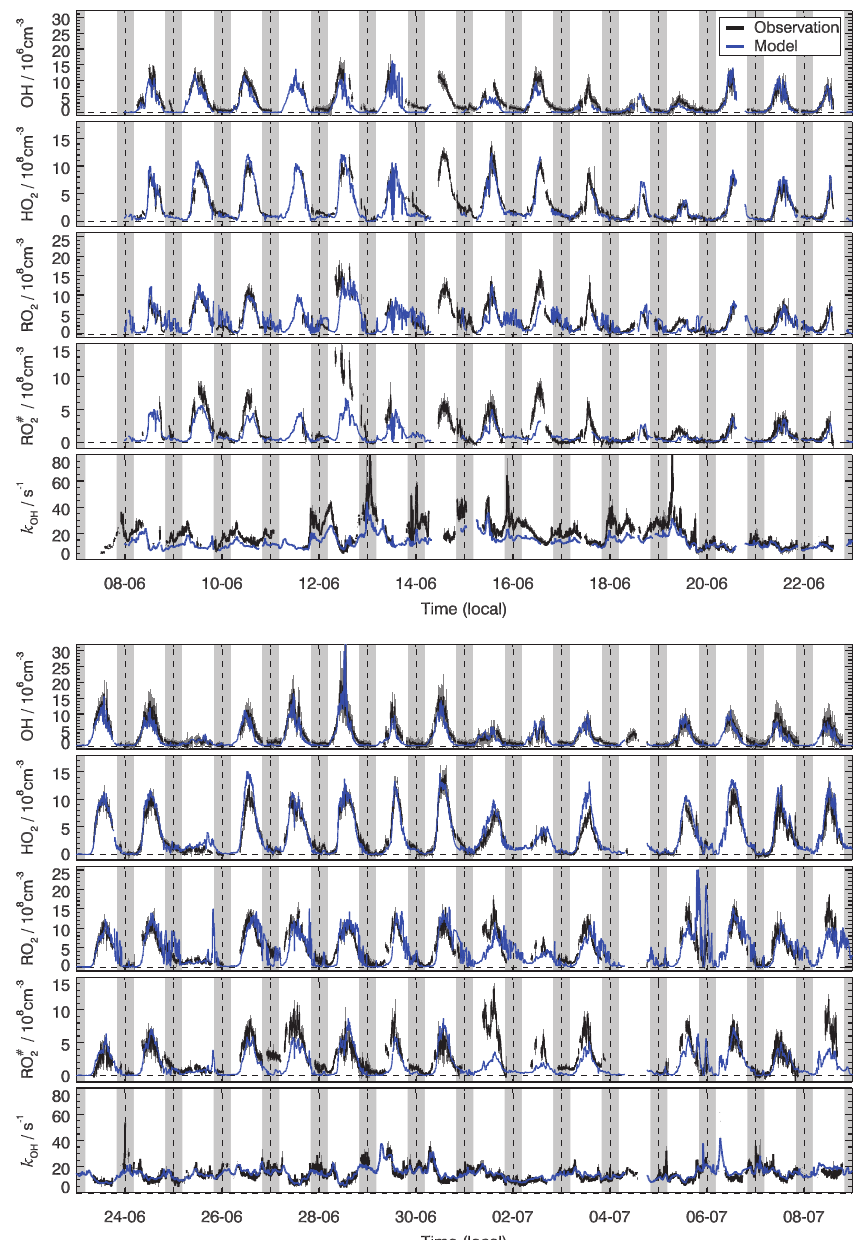
Figure 4. Time series of measured and modeled OH, HO 2 , RO # , total RO 2 concentrations and k OH . Vertical dashed lines denote mid- 2 night. See text for details on the definition of RO # and total RO 2 . Grey vertical lines denote 1 σ standard deviation for measured radicals’ 2 concentration with respect to 5min variability. Grey areas indicate